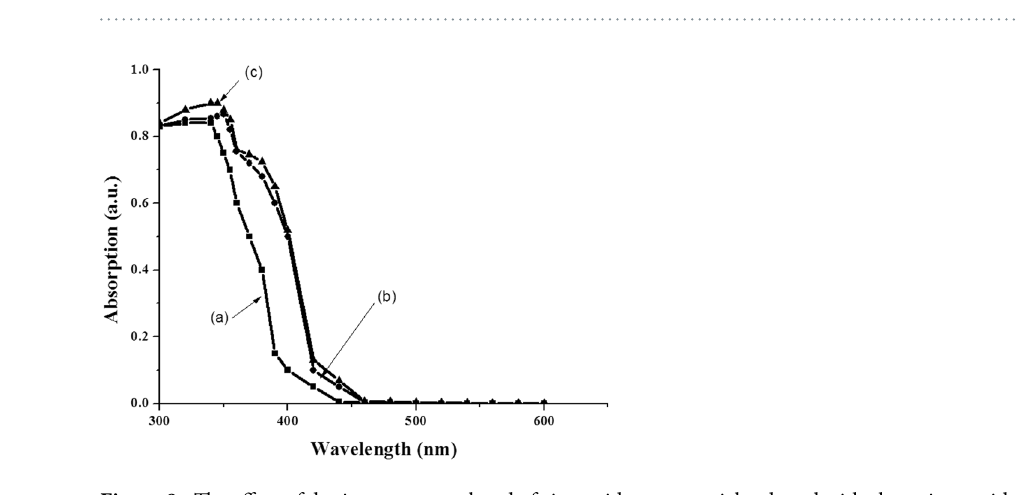
Figure 8. The effect of doping on energy band of zinc oxide nanoparticles doped with chromium oxide. ( A ) Pure powder of zinc oxide; ( B ) Zinc oxide doped with chromium oxide type 1; ( C ) Zinc oxide doped with chromium oxide type